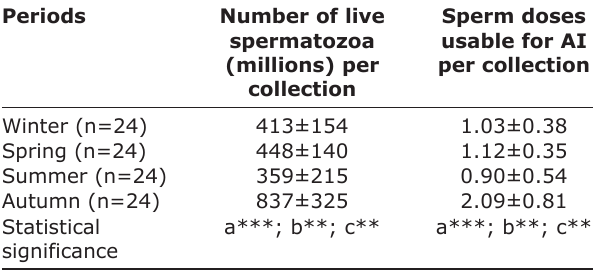
Table-3: Average number of live spermatozoa and sperm doses usable for AI (400×10 6 spz live) obtained per ram per